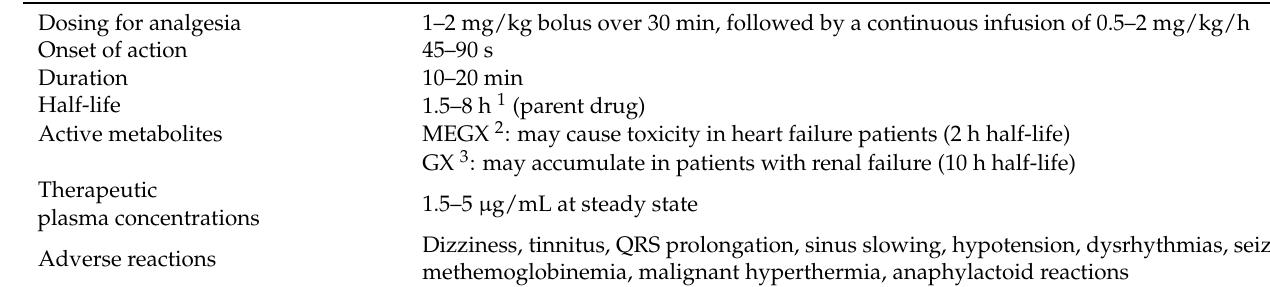
Table 3. Intravenous lidocaine